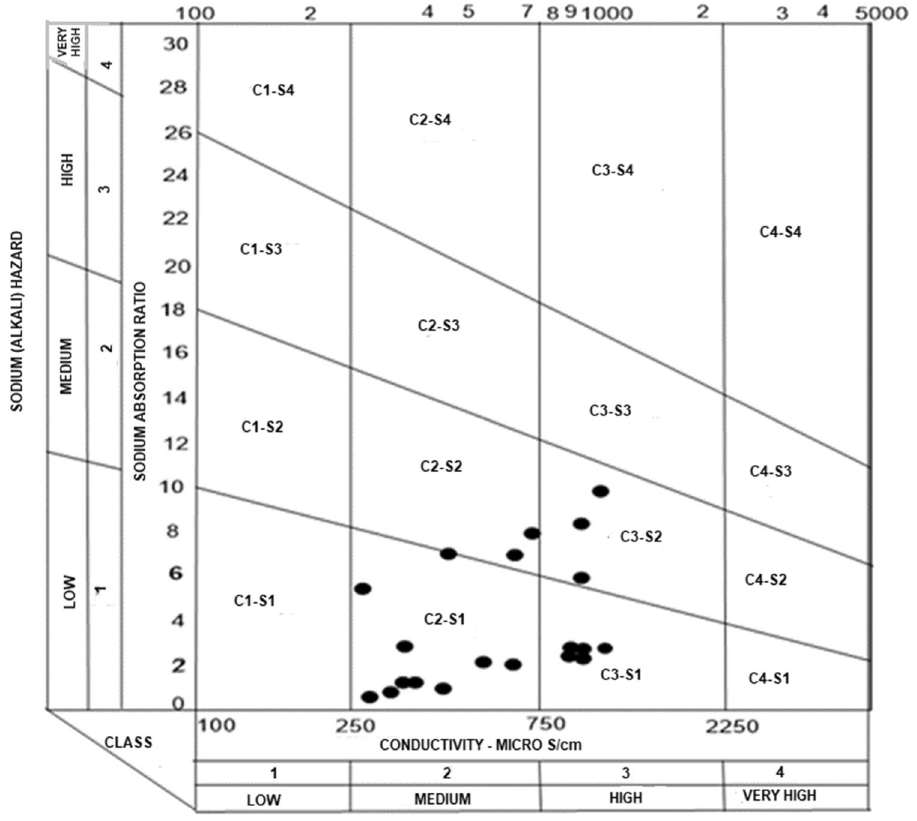
Fig. 8 USSL diagram for